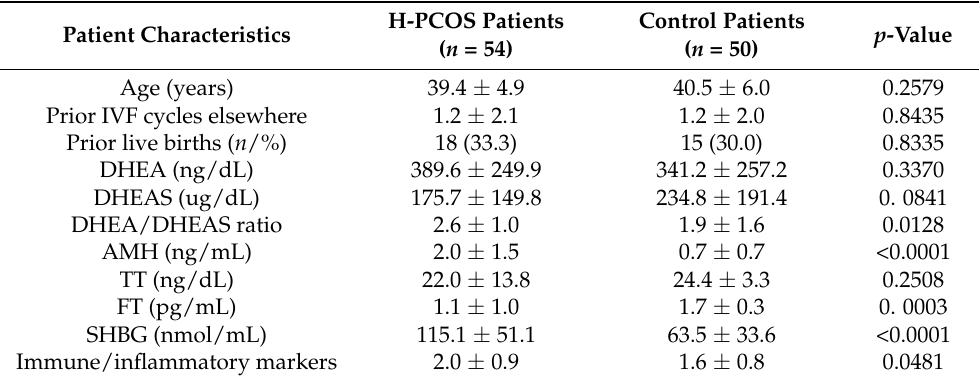
Table 3. HH-PCOS and control non-PCOS patient